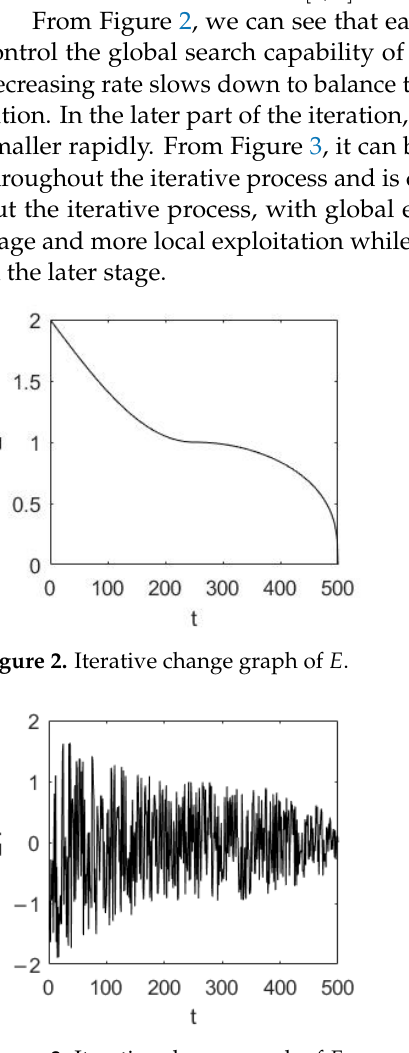
Figure 3. Iterative change graph of E 1